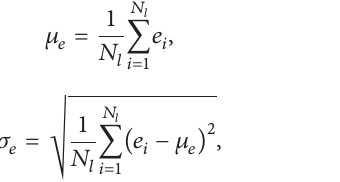
defined as the diameter of the innermost circle. For each outer circle the radius is increased by 𝑅 sequentially. CIRCLES can reduce collinearity of the anchor points; all areas within the concentric circles can be localized. However, CIRCLES leaves four corners of the ROI uncovered. The path length of CIRCLES can be calculated by using